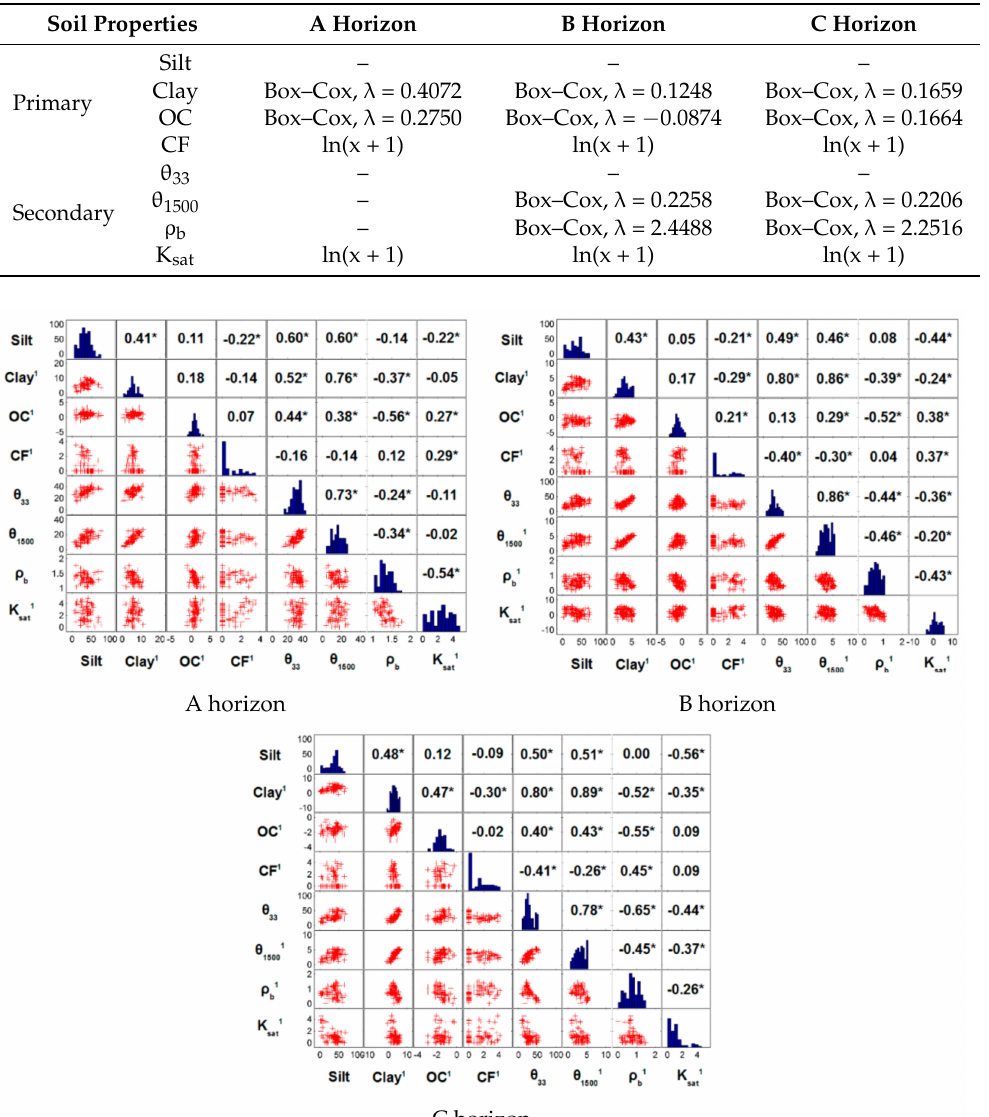
Table 3. Normal distribution transformations of soil properties.